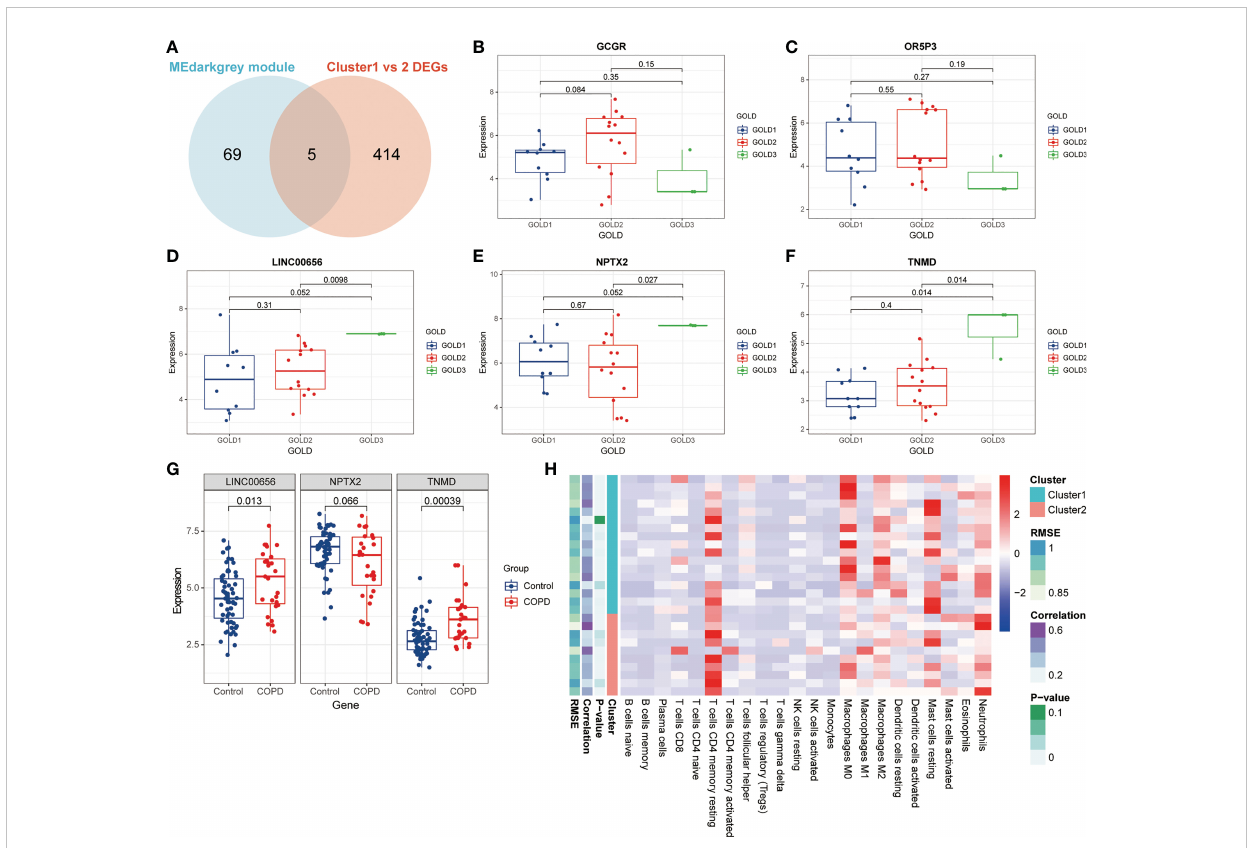
FIGURE 5 Identi fi cation of putative molecular targets involved in anoikis in COPD. (A) A Venn diagram showed the intersection of the genes from the MEdarkgrey module (blue) and the DEGs between Cluster1 and Cluster2 (red). (B-F) Boxplots showing the differential expression of (B) GCGR, (C) OR5P3, (D) LINC00656, (E) NPTX2, and (F) TNMD across various GOLD stages. (G) The boxplot showing the differential expression of LINC00656, NPTX2, and TNMD in control subjects and COPD patients. (H) The heatmap showing the in fi ltration level of 22 immune cells in Cluster1 subtype samples versus Cluster2 subtype